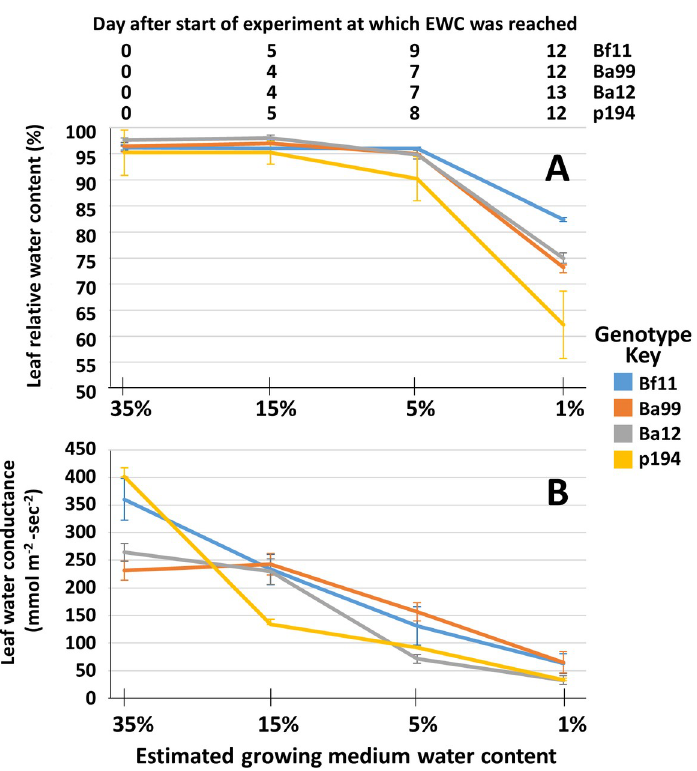
Fig 1. Indicators of increasing water stress with sampling points. (A) Leaf relative water content and (B) leaf water conductance for the 4 genotypes at the estimated growing medium water content (EWC) sampling points. Error bars represent the standard errors across the 4 replicates at each EWC sampling point. The days after the start of the experiment at which the EWC sampling point was reached is given above panel A.